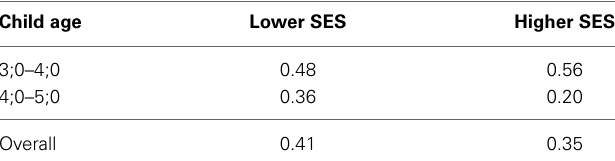
Table 4 | Proportion of letter sequences that are alphabetic order sequences in analysis 3, by SES and child age.